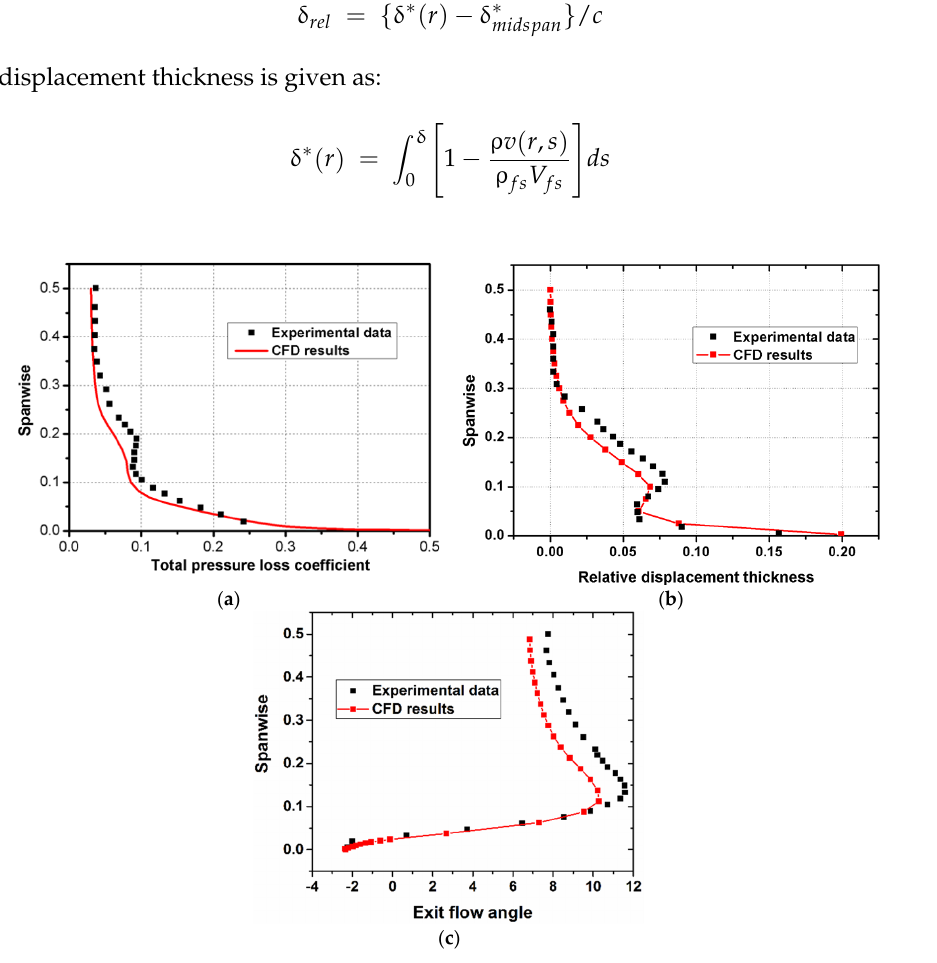
Figure 3. Spanwise distribution of pitch ‐ averaged flow parameters at the EXP test plane: ( a ) pitch ‐ averaged total pressure loss coefficient; ( b ) relative displacement thickness; and ( c ) exit flow angle .